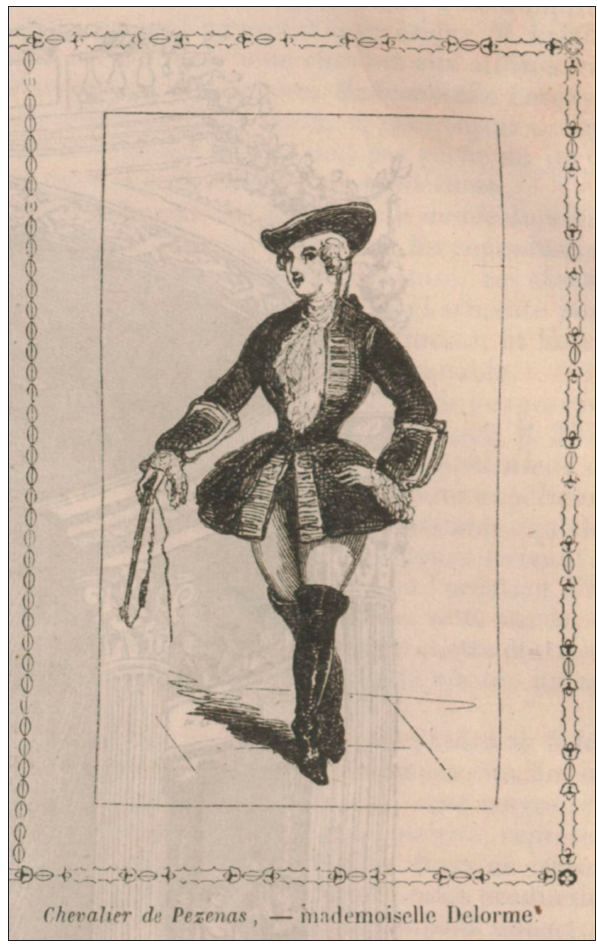
Fig. 1 : Mademoiselle Delorme, Le Daguerréotype théâtral , 19 February 1851, Bibliothèque nationale de France. With thanks to James Illingworth for finding this visual depiction of Mlle